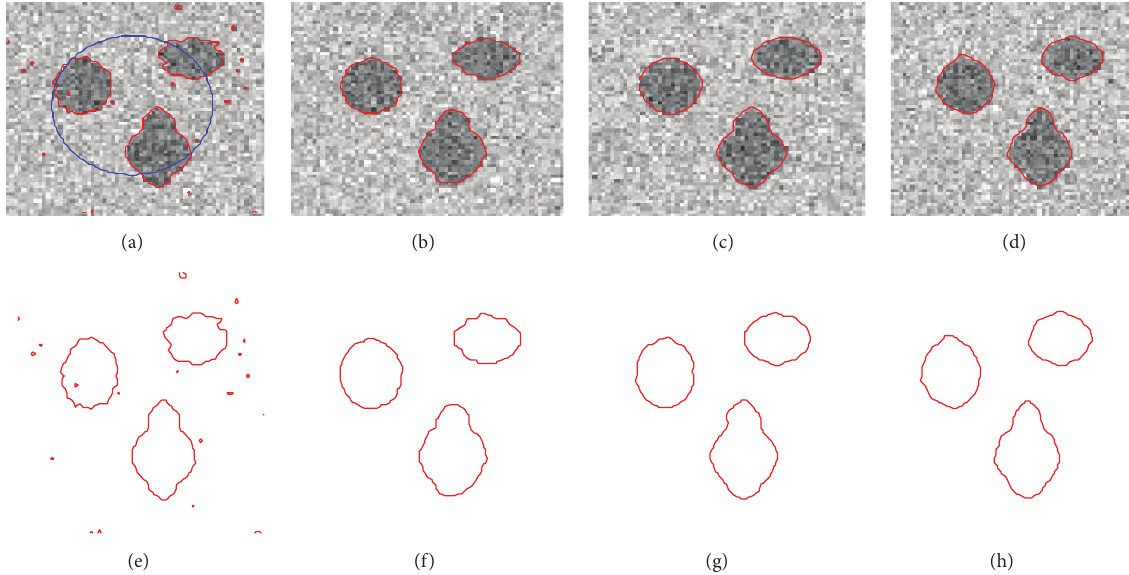
Figure 1: Segmental results of a noisy image with Gaussian variance 0.05. (a) Segmental result with CV model and the blue curve is the initial contour ( 𝜇 0 = 0.02∗255∗255 ). (b) Segmental result with TV-based segmentation model. (c) Segmental result with adaptive TV-based model. (d) Anisotropic diffusion-based segmentation model. (e), (f), (g), and (h) are the corresponding contours to (a), (b), (c), and (d), respectively.